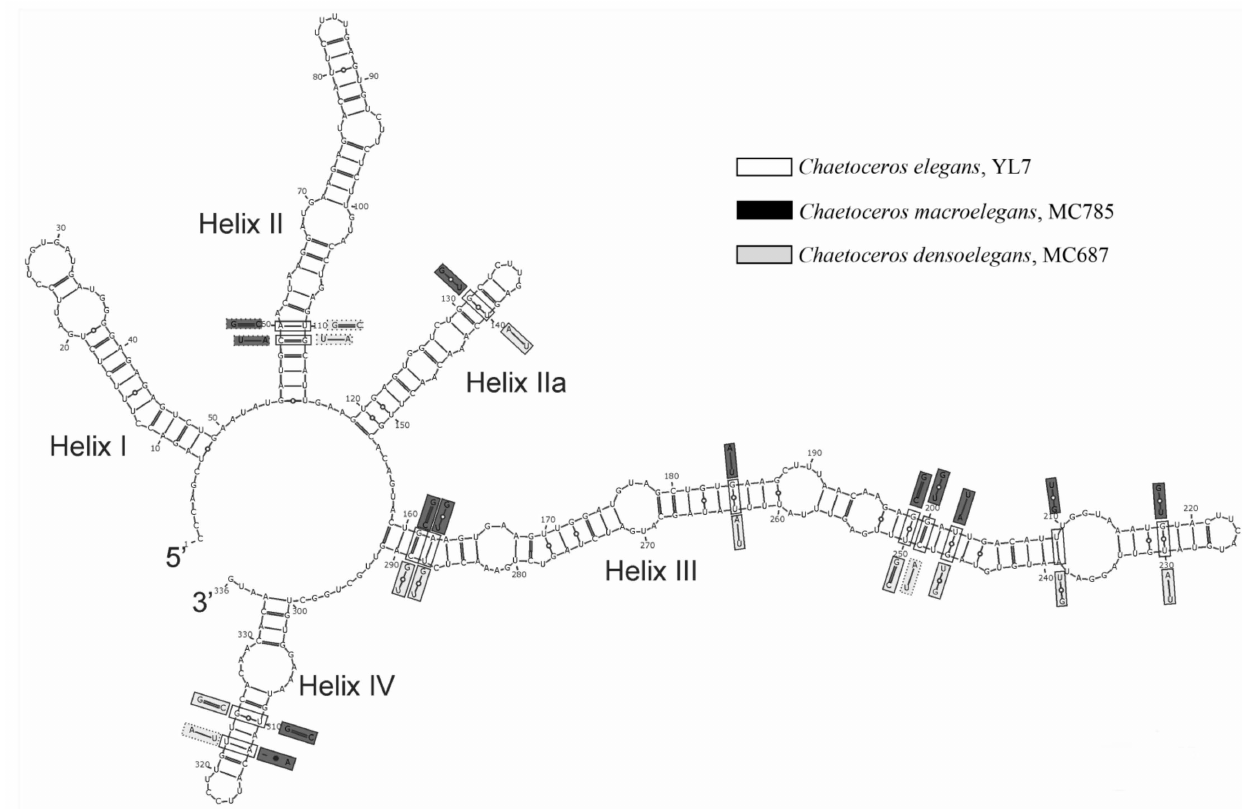
Figure 9. ITS2 RNA transcript of Chaetoceros elegans (strain YL7), with four common helices and one pseudo-helix II. CBCs and HCBCs between C. elegans and C. macroelegans (MC785), C. densoelegans (MC687) were indicated by rectangles, with dotted line and solid line, respectively. The base pairs of C. elegans , C. macroelegans and C. densoelegans are noted in white, black and grey,